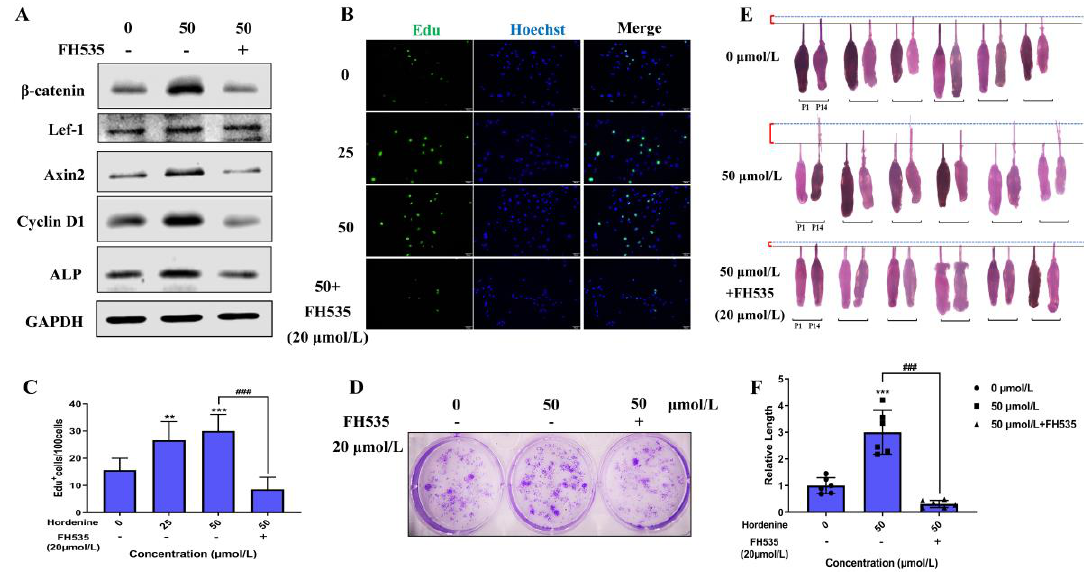
Figure 5. Hordenine increased DPCs’ proliferation and hair follicle regrowth by activating Wnt/ β - catenin signaling pathway. ( A ) Western blot analysis of β -catenin, Lef1, Axin2, CyclinD1 and ALP in DPCs treated with Hordenine or co-treated with FH535. ( B ) Images of EdU staining in DPCs treated with or without Hordenine for 24 h. The nuclei were counterstained by DAPI (blue). Scale bar, 50 µ m. ( C ) The percentage of EDU-positive DPCs, n = 5. ( D ) Representative images of colonies formed by DPCs treated with Hordenine or co-treated with FH535. ( E ) Mouse vibrissa follicles were isolated and cultured in William’s E with Hordenine in the presence or absence of FH535 (20 µ mol/L) for 14 days. Indicate images of mouse vibrissa follicles at day 1 and 14, respectively ( n = 6). ( F ) The elongation length of mouse vibrissa follicles after Hordenine’s treatment for 14 days ( n = 6). Data are expressed as means ± SD. ** p < 0.01, *** p < 0.001, Hordenine versus control; ### p < 0.001, Hordenine versus Hordenine plus FH535.